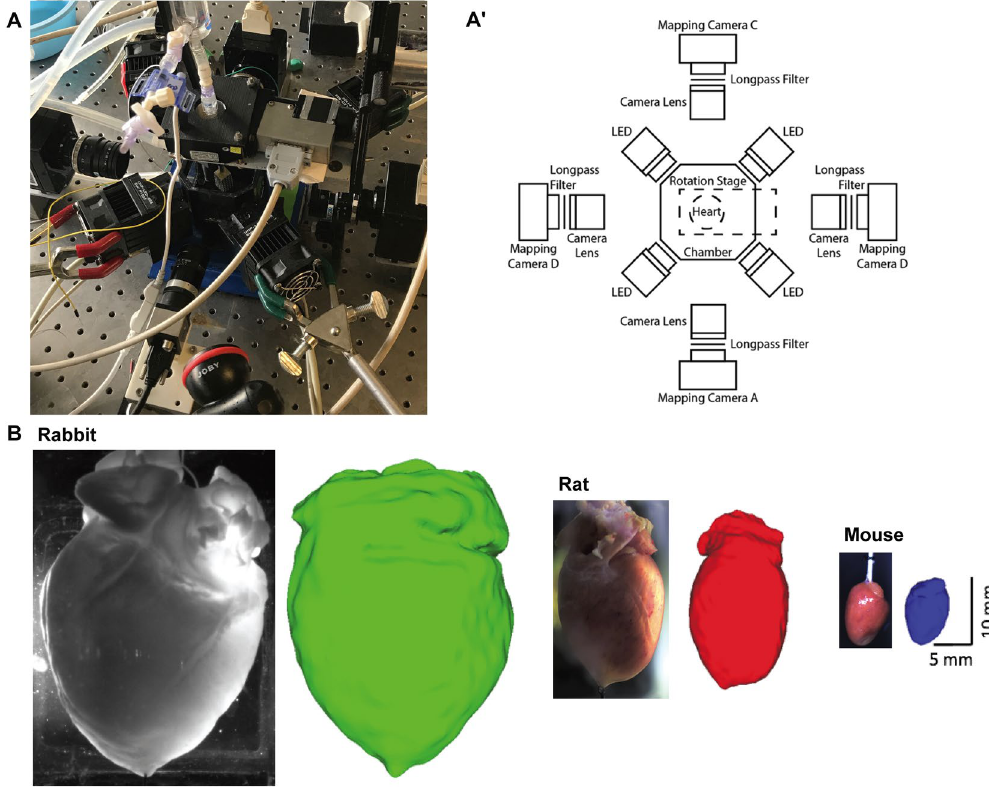
Figure 9. Panoramic optical mapping system. ( A ) Picture and schematic of the optical mapping system are shown. In addition to increasing the number of optical cameras, we designed, and 3D printed a number of experimental components including the perfusion chamber. ( B ) Representative rabbit, rat and mouse hearts and the corresponding reconstructed